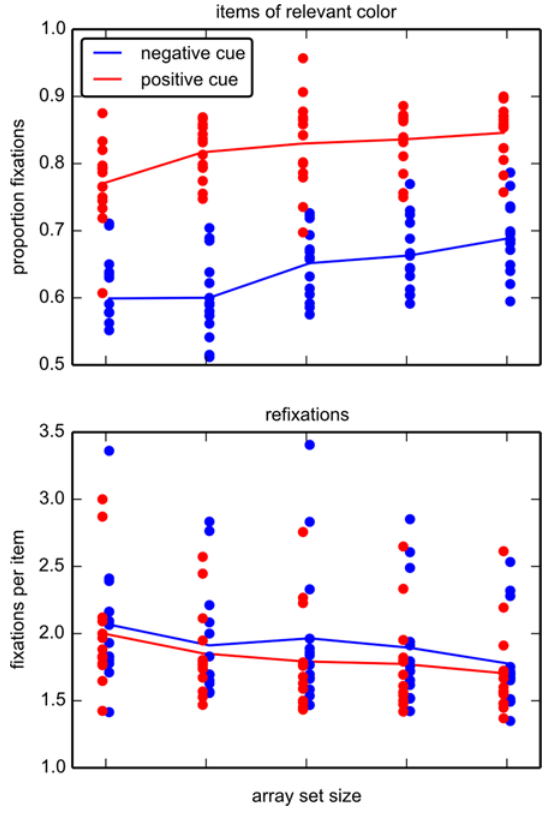
Fig 5. Fixations in experiment 1. (Top) The proportion of fixations on the relevant half of items is shown (only target absent trials). In positive cue (blue), relevant items are of the color given in the instruction. These items are spatially identical in the negative cue (red), but of various colors. Dots depict mean values of each individual, lines are the means for each group. As half of the items are relevant and half of the items irrelevant, 0.5 represents chance level. (Bottom) Number of fixations per fixated item. Items are refixated significantly more often in negative cue (red) compared to positive cue (blue), despite high individual